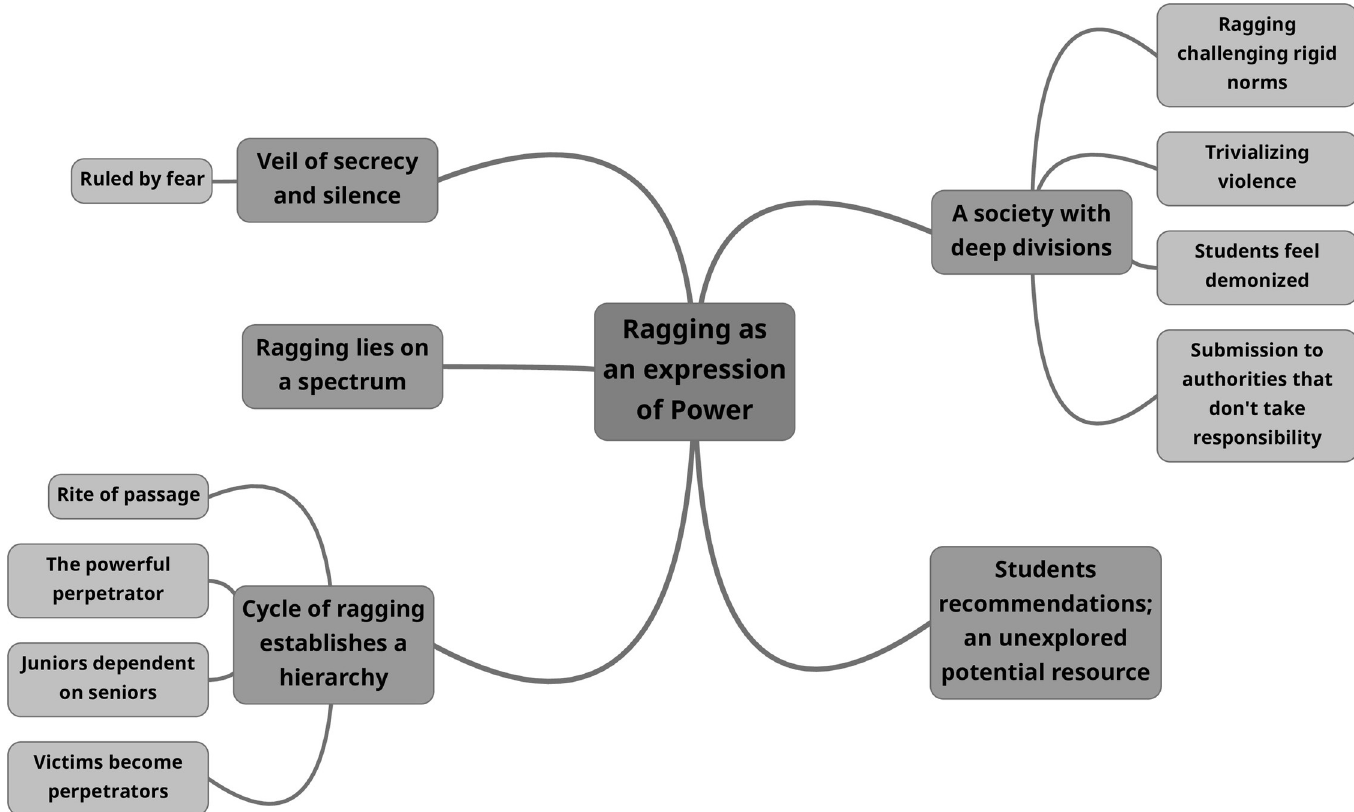
Fig 2. Main theme and subthemes derived from the analysis of student focus group discussions.